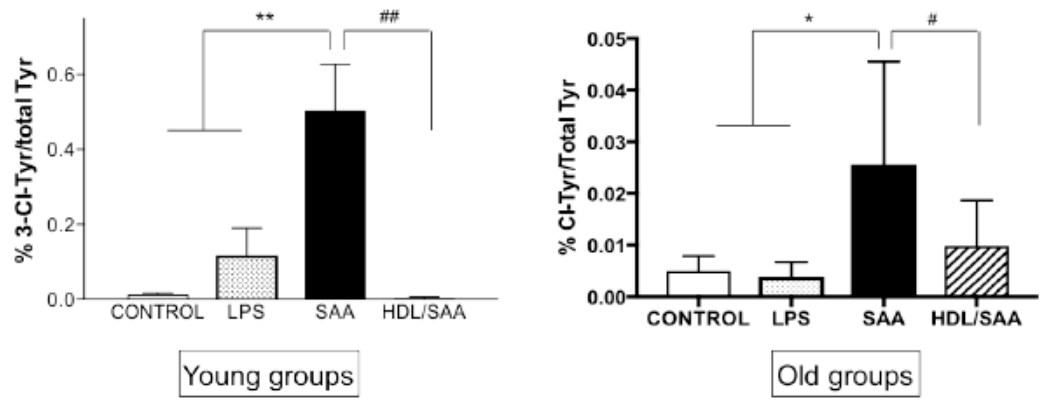
Figure 9. SAA ‐ induced increase in kidney tissue 3 ‐ Cl ‐ Tyr levels in young and old cohorts of Apo E ‐ / ‐ mice. Mice were allocated into 4 treatment arms and administered with vehicle (control), LPS, SAA alone, or SAA in combination with HDL. Mice were monitored for 4 weeks ( A , young cohort) or 18 weeks ( B , old cohort) after commencement of treatment, then sacrificed and kidneys were harvested and processed, and the levels of 3 ‐ Cl ‐ Tyr were determined by liquid chromatography coupled with mass spectrometry, as described in methods section. Data represent mean ± SD with mice numbers were control ( n = 5), LPS ( n = 5), SAA ( n = 5), and HDL/SAA ( n = 5). Different to the respective controls, * p ˂ 0.05, ** p < 0.01; different to the respective SAA and HDL/SAA group, # p ˂ 0.05, ## p ˂ 0.01.